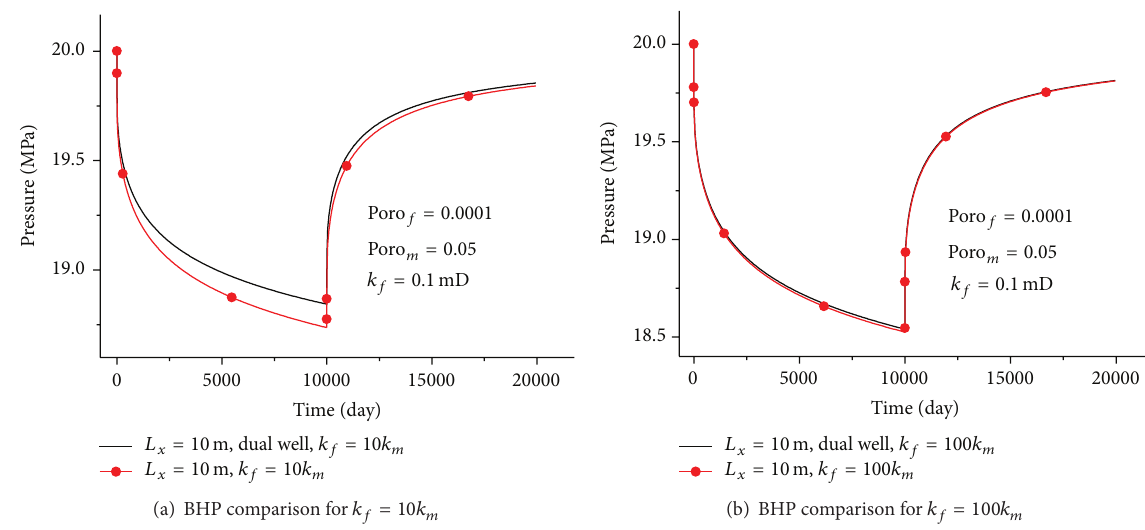
Figure 4: Effect of flow during matrix and wellbore on BHP under 𝐿 𝑥 = 10 m and 𝑄 = 10000 m 3 / day.